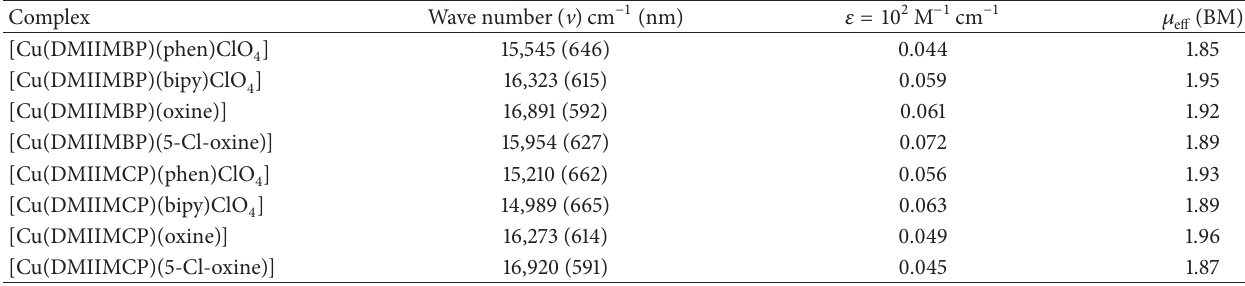
Table 3: Electronic spectral data and magnetic susceptibility values of the Cu(II) complexes. Complex